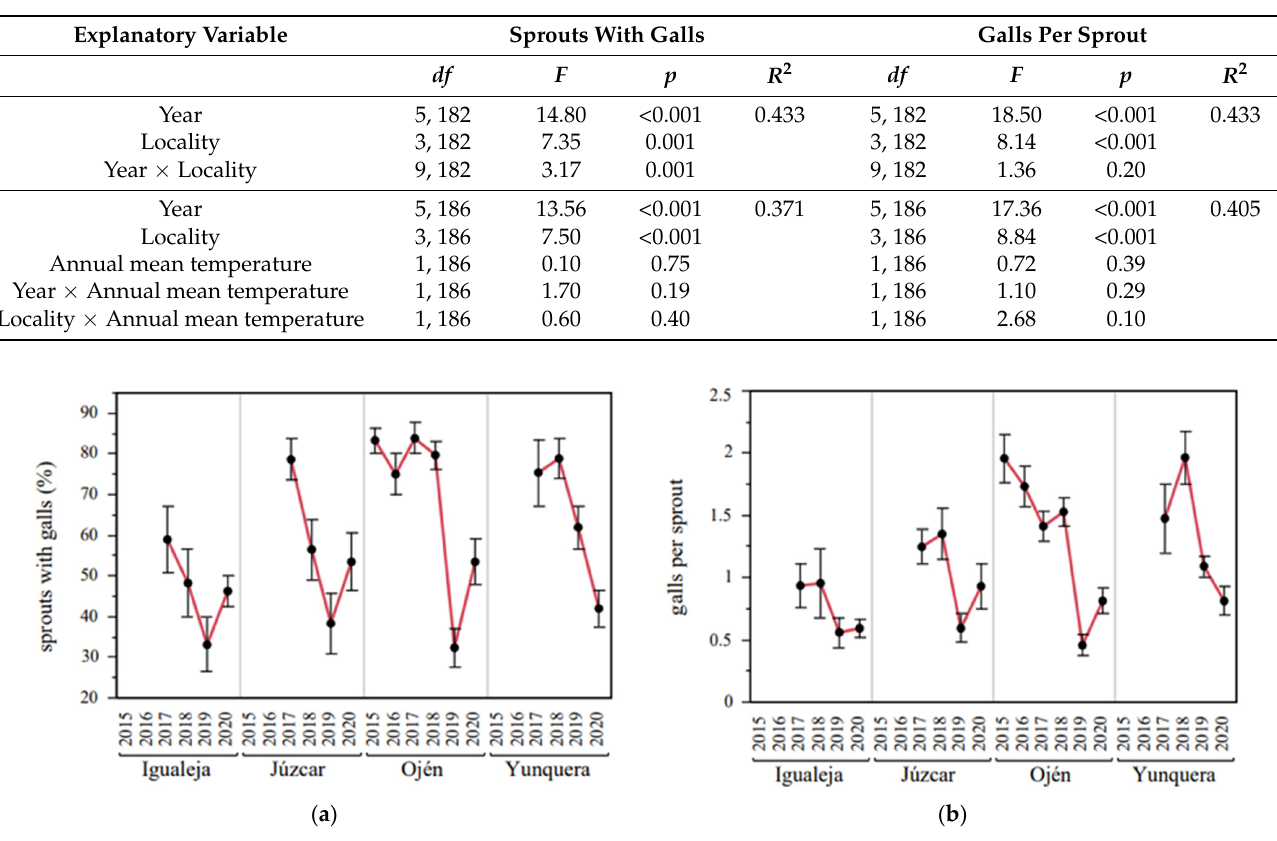
Figure 5. CGW damage levels across years and localities. ( a ) Year × locality effects on the rate of sprouts with CGW galls. ( b ) Year × locality effects on the number of CGW galls per sprout. See locality × year clustered heatmap in Figure S3.